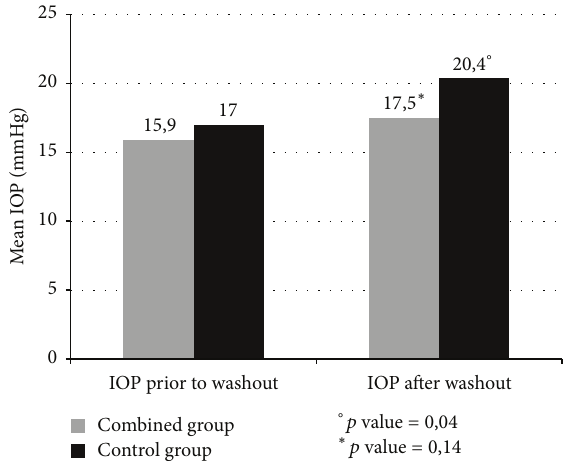
Figure 2: Mean intraocular pressure (IOP) at long-term follow-up before and after washout of ocular hypotensive medications at long- term follow-up ( 𝑝 values prior to and after washout: 0,14 in the combined group and 0,04 in the control group). Table 2: Ocular hypotensive medications by visit (mean values). Baseline 12 months 48